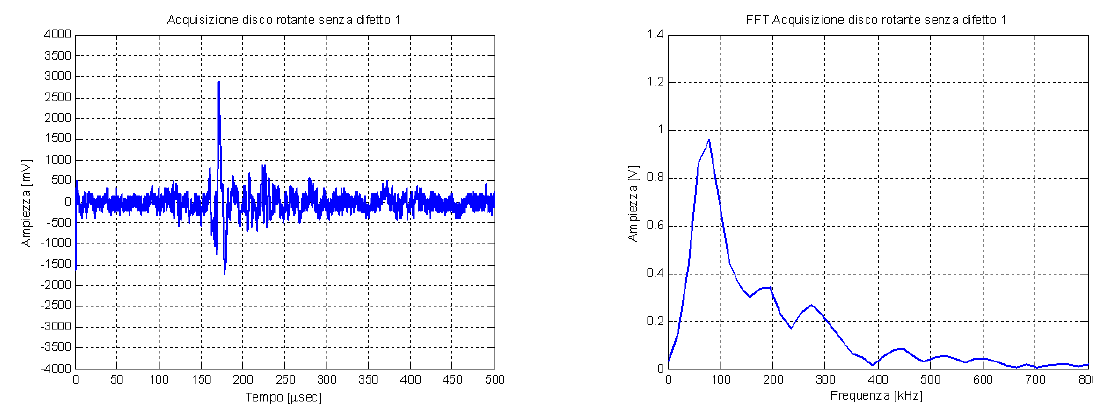
Figura 11: Segnale acquisito con disco rotante in assenza di difetto e relativa trasformata di Fourier. Figure 11: Signal acquired on the rotating disk, without defect, and its Fourier transform.